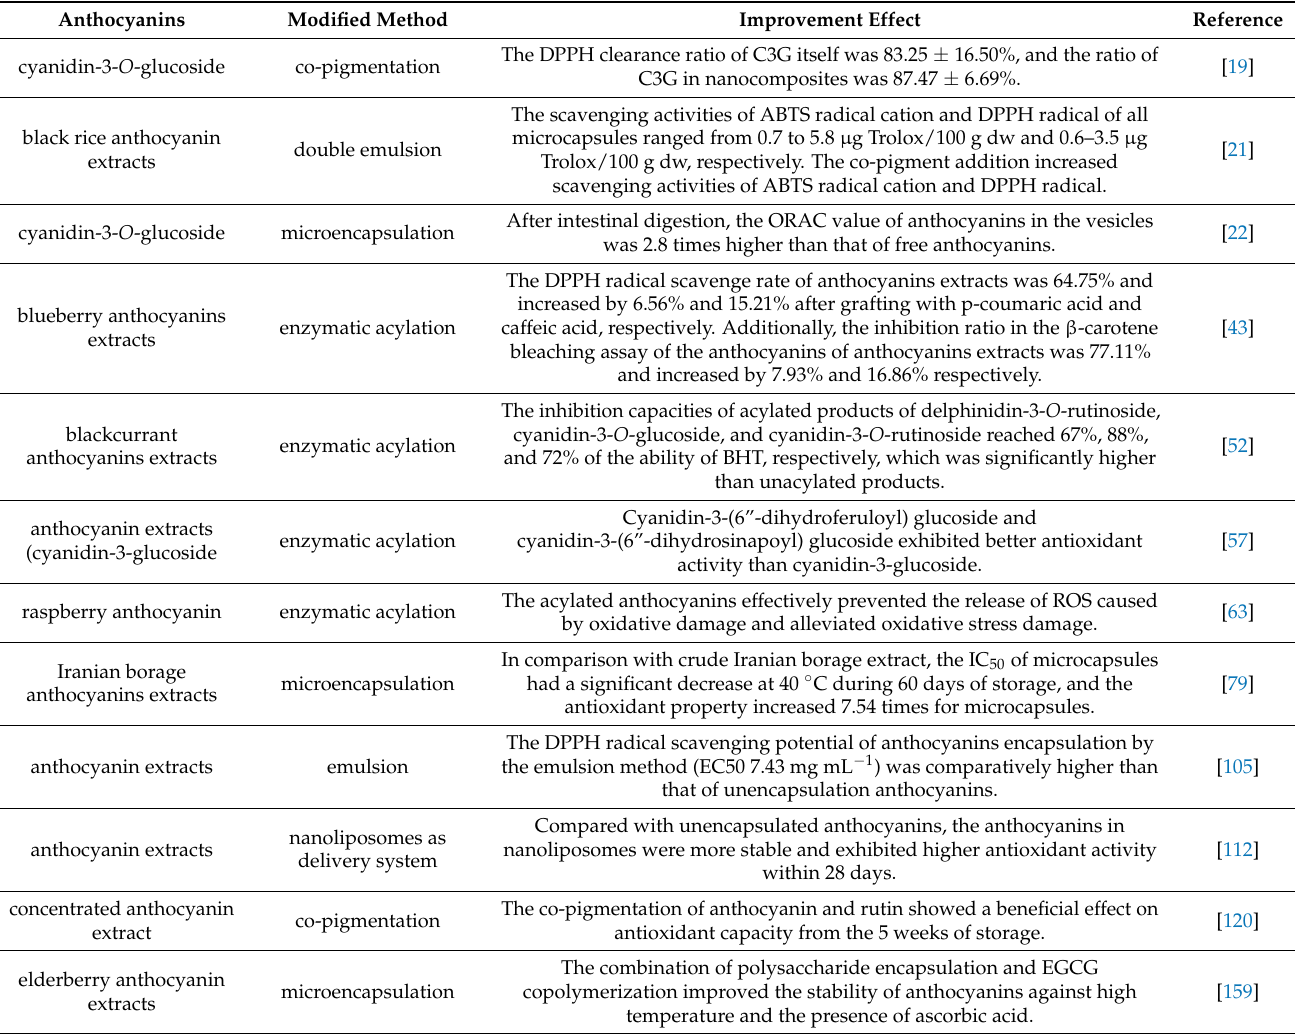
Table 6. Antioxidant properties of anthocyanins and modified